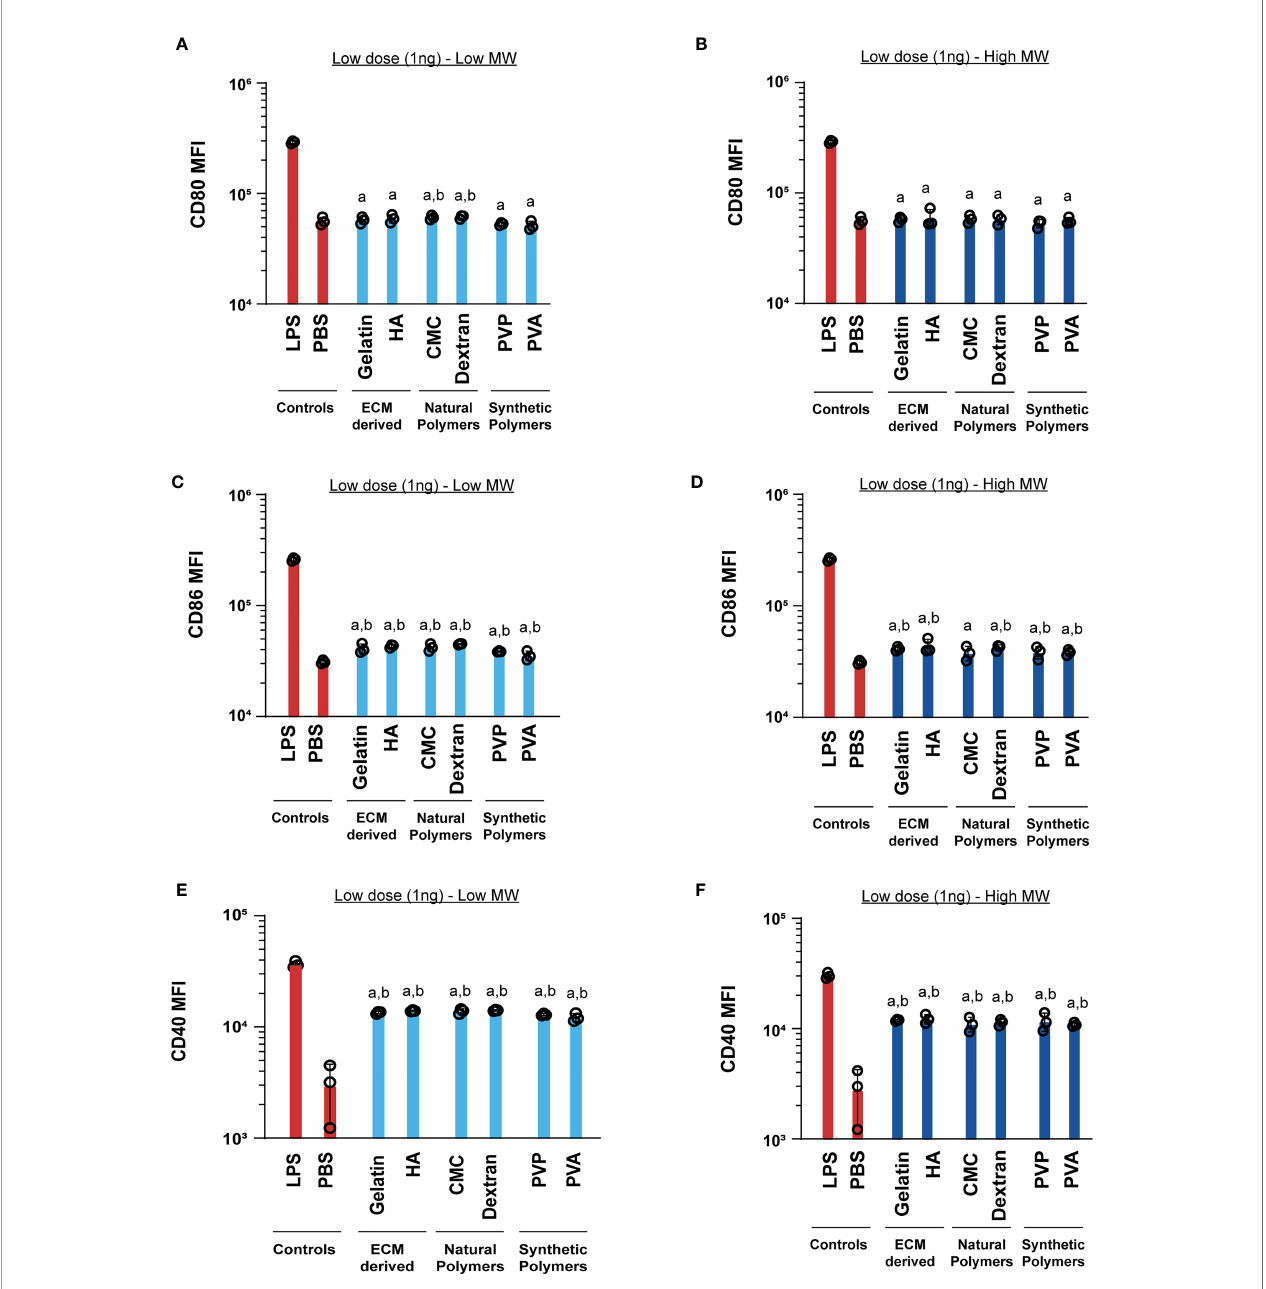
FIGURE 4 | Low (1ng) doses of both high and low MW polymers lead to low activation levels. Activation of DCs treated with low or high MW polymers at low doses, respectively, as indicated by expression of (A, B) CD80, (C, D) CD86 and (E, F) CD40. “ a ” and “ b ” represents signi fi cant statistical differences (p < 0.05) when compared with LPS and PBS group